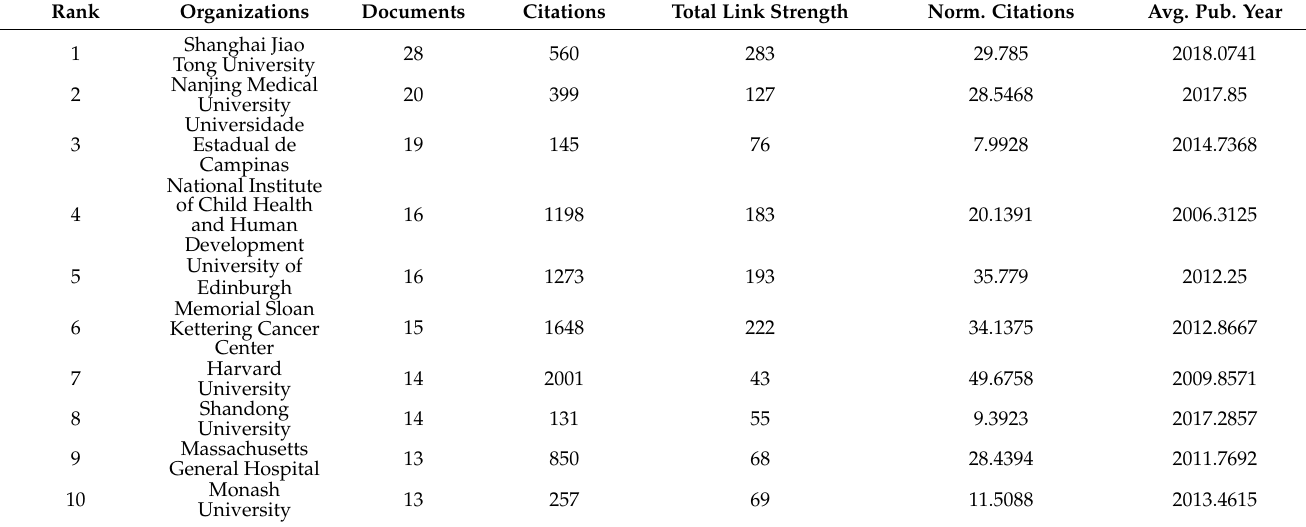
Table 2. Top 10 most productive organizations on therapy for POI from 2000 to